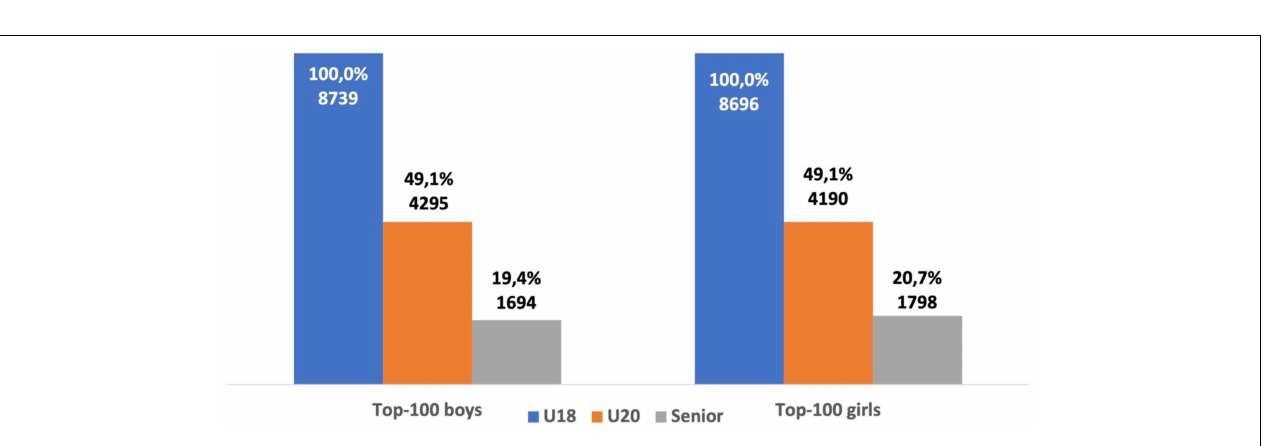
FIGURE 4 | Career trajectory of U18 male and female athletes ranked in the